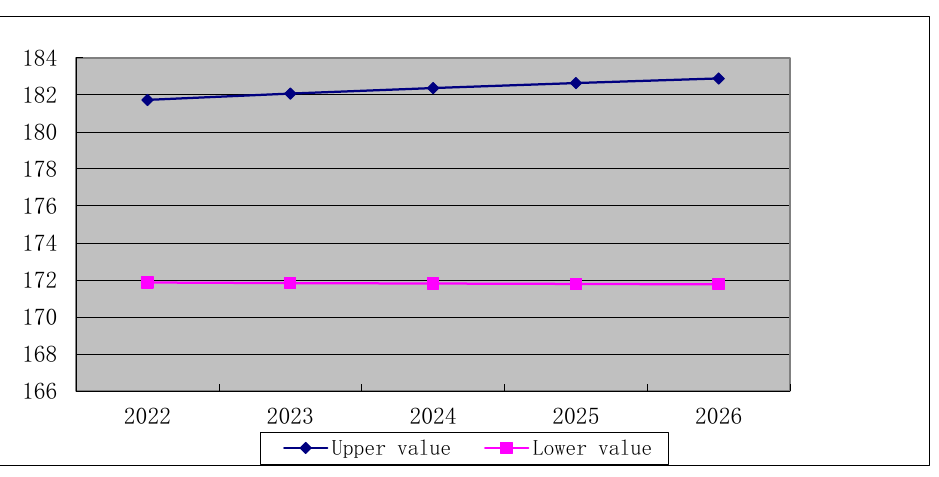
Figure 12. The variation interval of water requirement with the influence of the tertiary industry in Hebei.